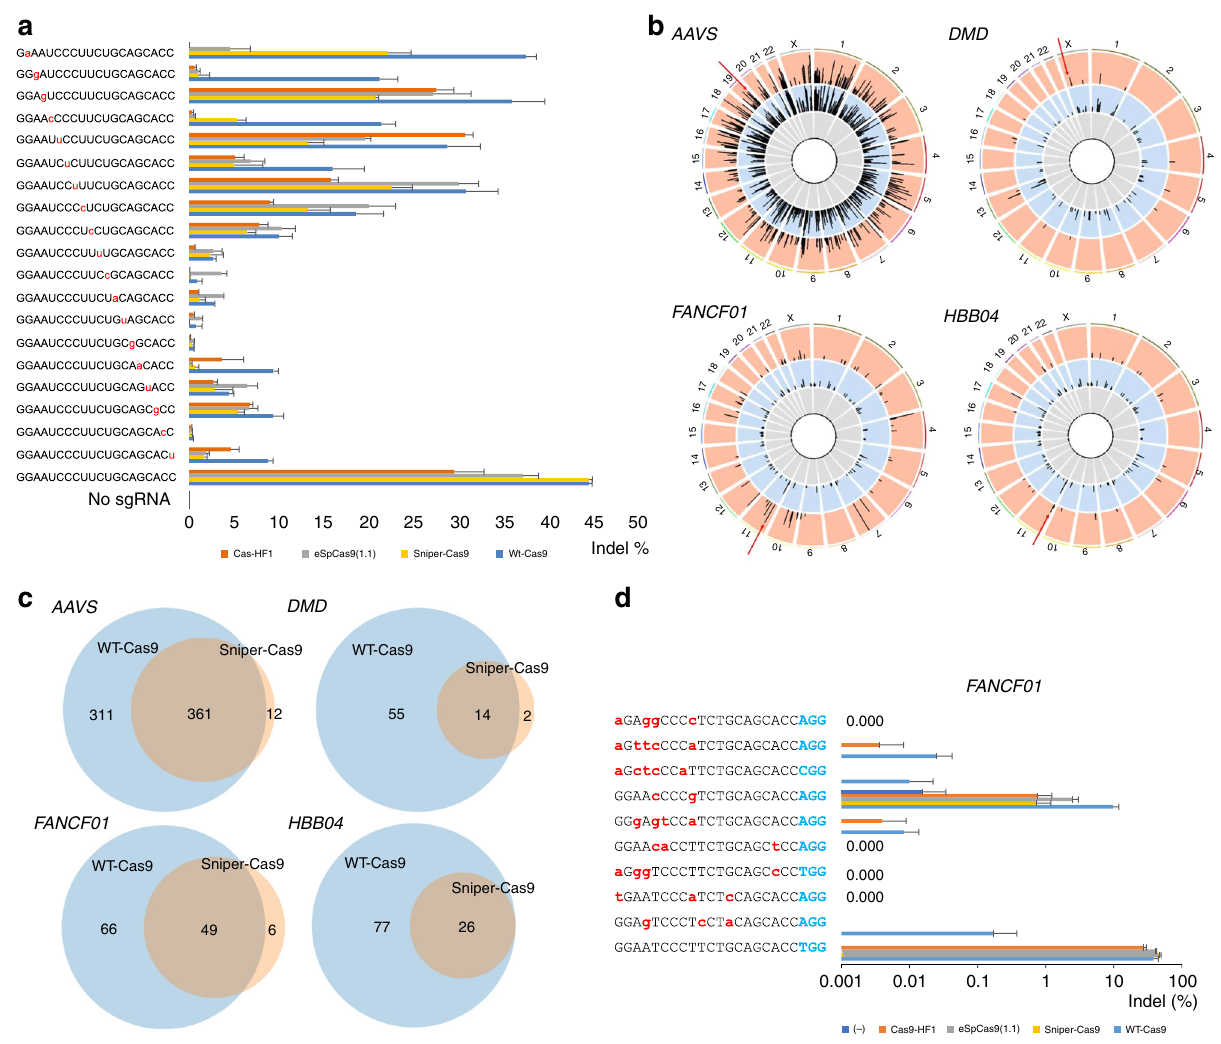
Fig. 4 Unbiased genome-wide off-target analysis of Sniper-Cas9 using Digenome-Seq. a Tolerance of Cas9 variants for sgRNAs with mismatches relative to the FANCF01 target. Frequencies of small insertions or deletions (indels) were measured using targeted deep sequencing. Error bars indicate s.e.m. ( n = 3). b Genome-wide Circos plots representing DNA cleavage scores for AAVS , DMD , FANCF01 and HBB04 obtained with genomic DNA digested with untreated (gray), WT-Cas9 (blue), or Sniper-Cas9 (orange). Arrows indicate on-target sites. c Venn diagrams showing the number of in vitro cleavage sites captured by multiplex Digenome-sequencing analyses. d WT-Cas9, eSpCas9 (1.1), Cas9-HF, and Sniper-Cas9 off-target sites for FANCF01 validated in HEK293T cells by targeted deep sequencing. Error bars indicate s.e.m. ( n = 3) The PAM is shown in